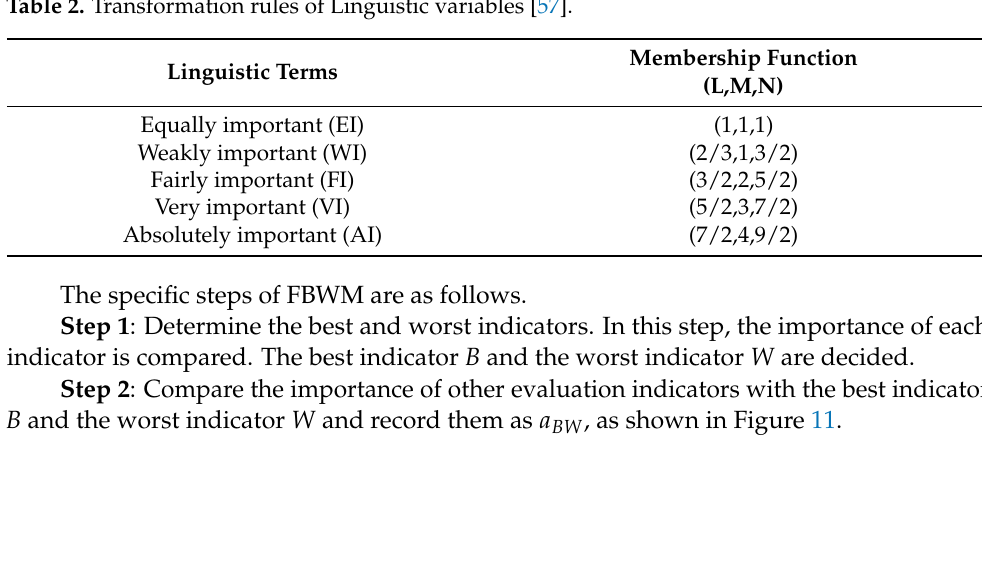
Table 2. Transformation rules of Linguistic variables